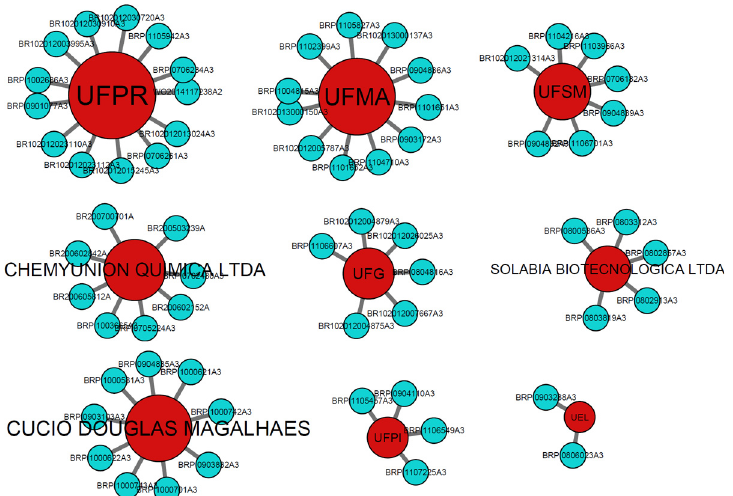
Figure 6. Components of the general (bipartite) network showing assignees with a reasonable number of patents, but who do not establish partnerships with other institutions in this